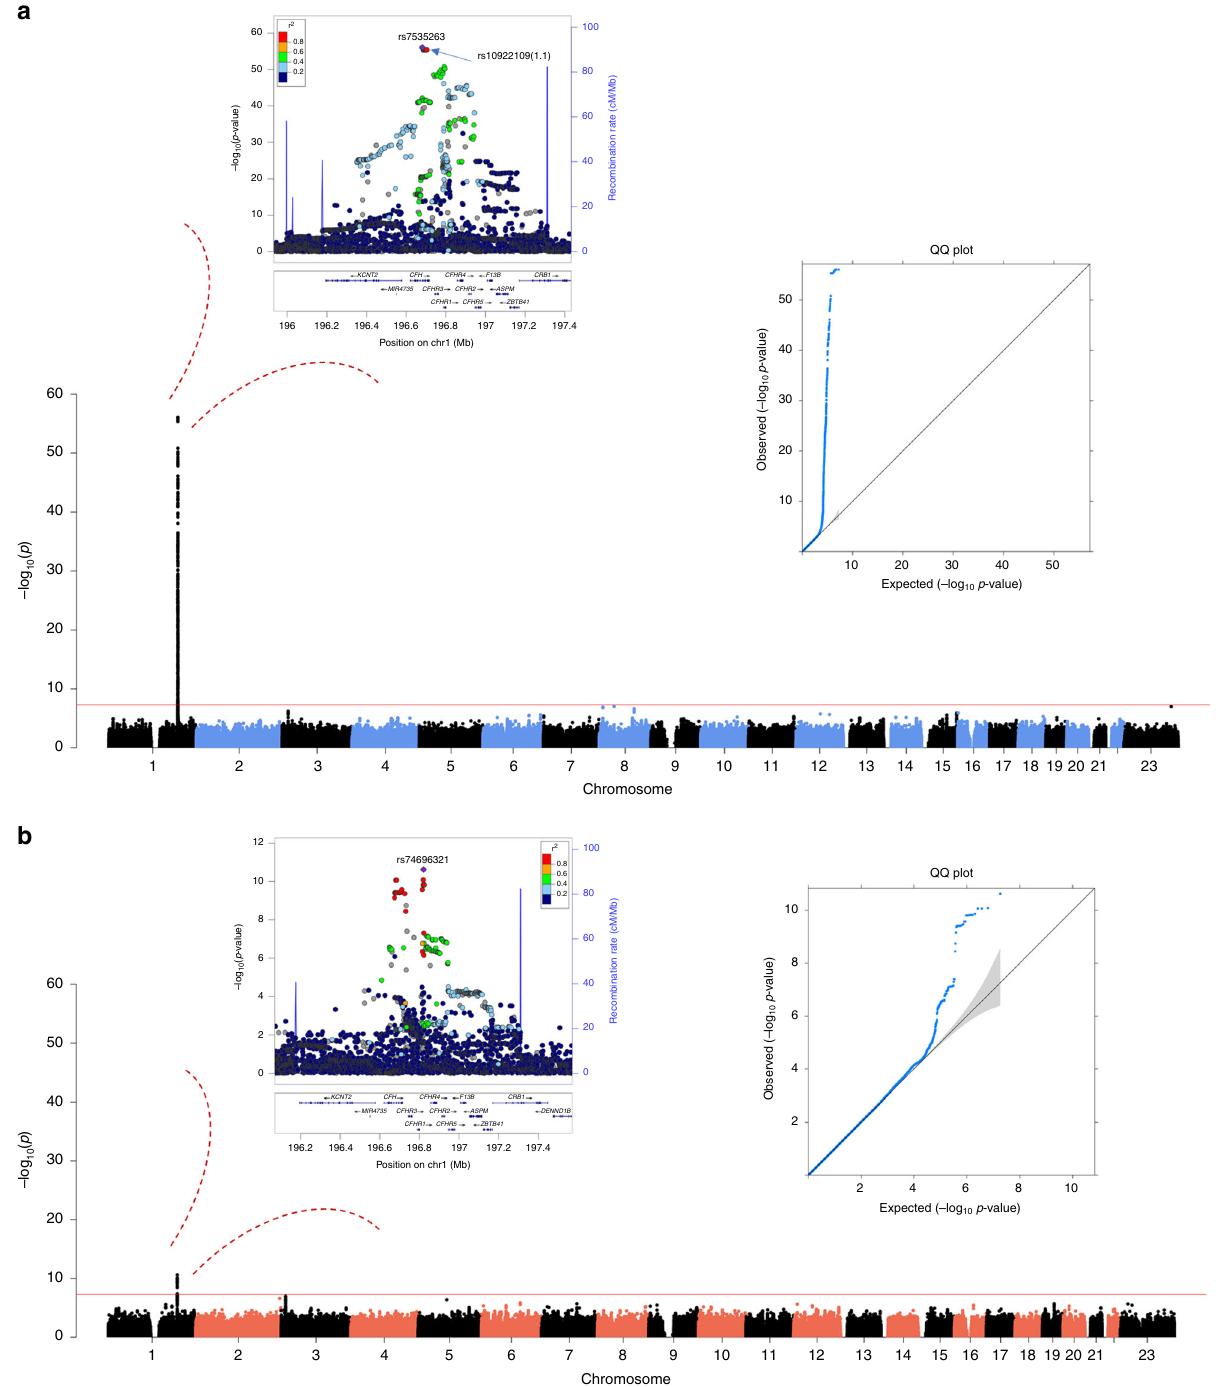
Fig. 4 GWAS meta-analysis of FHR-4 levels reveals a strong signal spanning the CFH locus. Each panel shows a Manhattan plot, a regional plot (upper left-hand side) and a quantile – quantile (QQ) plot (upper right-hand side) for the results of the GWAS meta-analysis of FHR-4 levels ( a ) and FH levels ( b ). Manhattan plots illustrate P values (Wald test) for each single variant tested for association with log(levels). Observed − log 10 ( P values) are plotted against the genomic position of each variant on chromosomes 1 – 22 plus the X chromosome. The horizontal red line indicates the threshold considered for genome- wide signi fi cance ( P value ≤ 5 x 10 − 8 ). Regional plots show the only genome-wide association signal observed, that is, at the CFH locus (on chromosome 1q31.3). The most associated variant is denoted by a purple circle and is labelled by its rsID. The other surrounding variants are shown by circles coloured to re fl ect the extent of LD with the most associated variant (based on 1000 Genomes data, November 2014). A diagram of the genes within the relevant regions is depicted below each plot. Physical positions are based on NCBI RefSeq hg19 human genome reference assembly. QQ plots compare the distribution of the observed test statistics with its expected distribution under the null hypothesis of no association. A marked departure from the null hypothesis (reference line) is seen in the meta-analysis of FHR4 levels. Genomic in fl ation values ( λ ) were equal to 1.008 and 1.005 from the GWASs of FHR-4 levels and 1.002 and 1.014 from the GWASs of FH levels, in the Cambridge and EUGENDA studies,